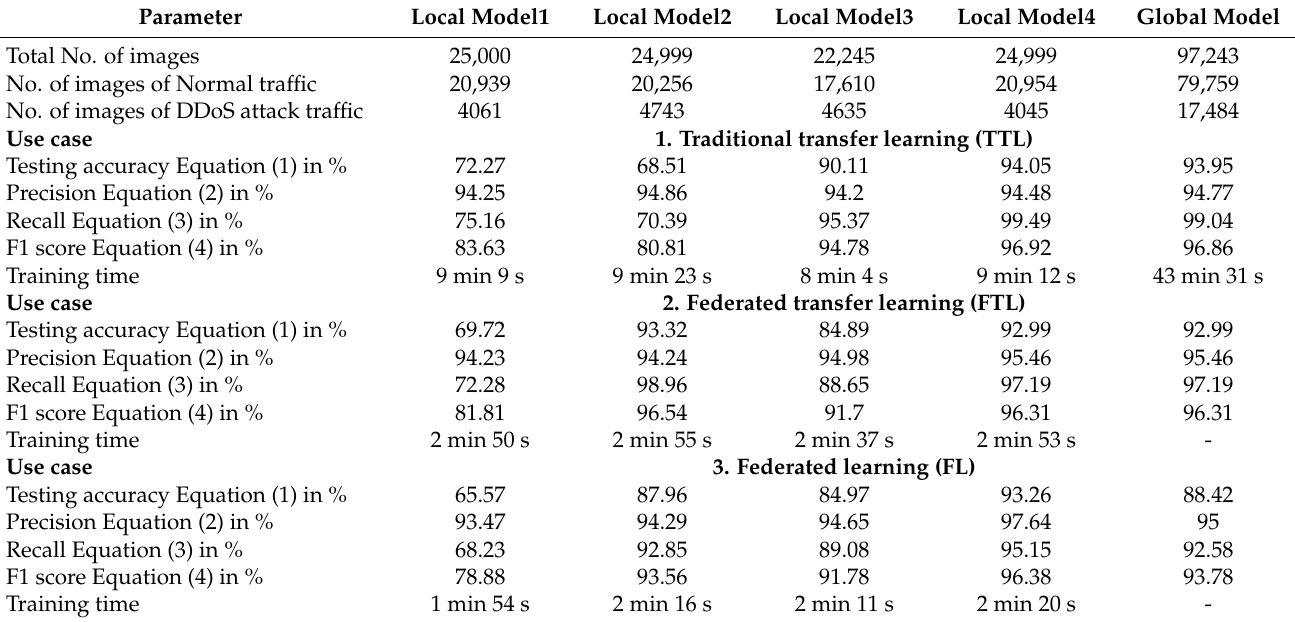
Table 5. Evaluation of the experimental